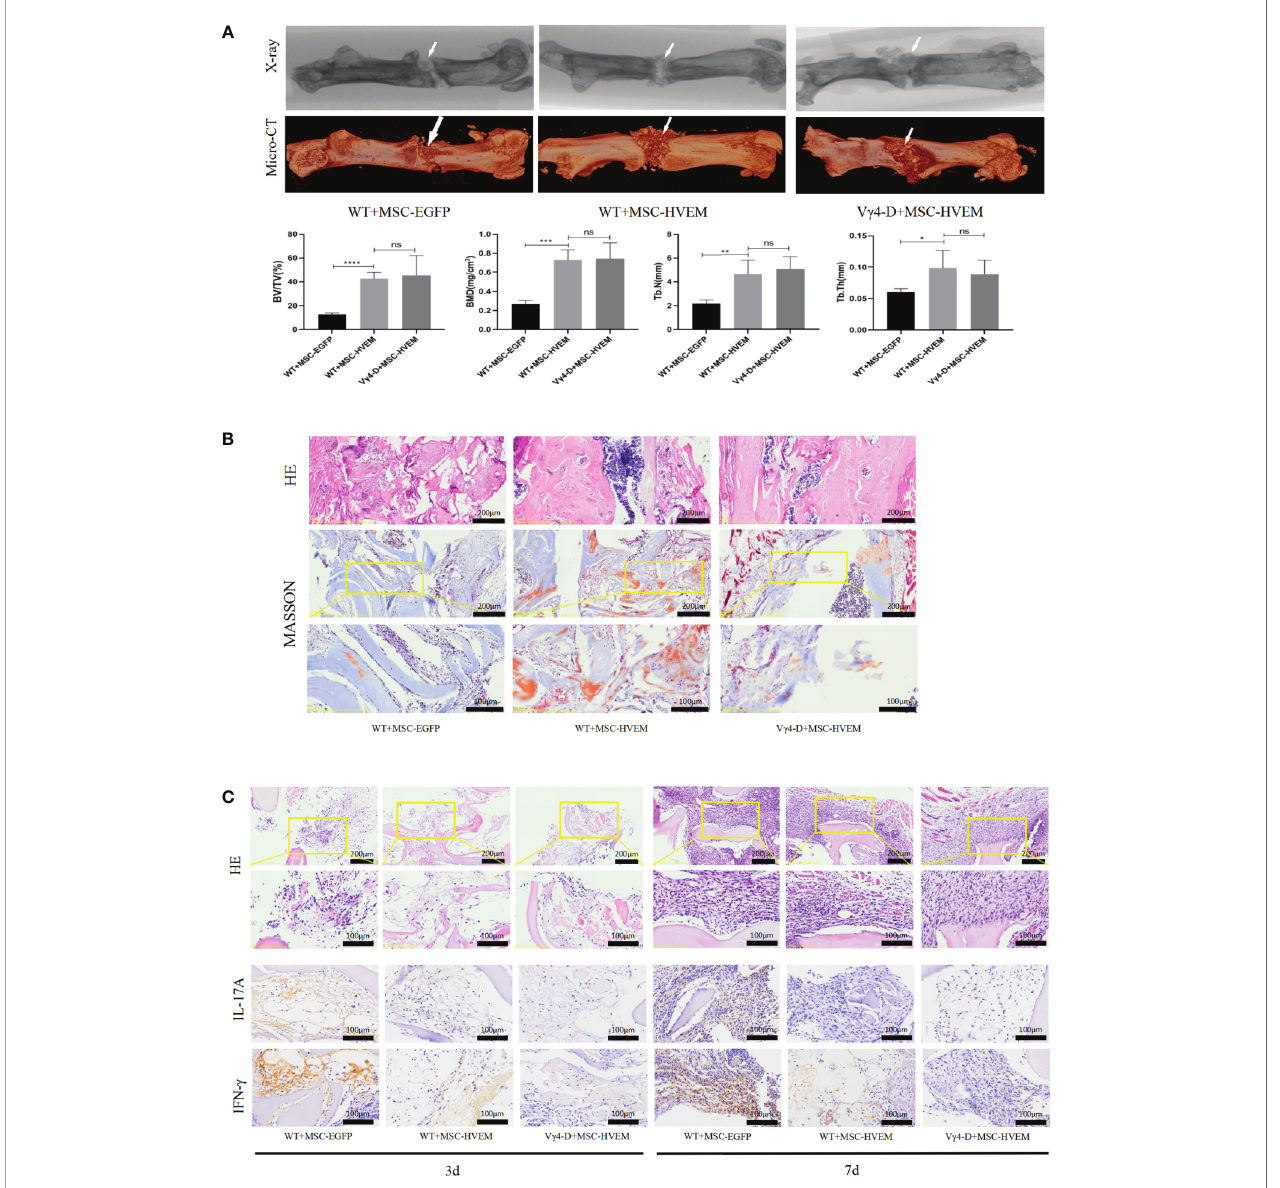
FIGURE 6 | OsteogenicabilityandLocal immuneresponseofTEB constructed byMSC HVEM invivo. (A) BothWT+MSC HVEM groupsandVY4-D+MSC HVEM groups show higher qualityofbone formationthanthat ofWT+MSC inBV/TV, BMD, Tb.N,Tb.Th, butthe qualityofbone formationofbetweenWT+MSC HVEM groups and VY4-D+ MSC HVEM groups hadno statisticsdifference(P > 0.05). (B) Histological analysis ofnewly formedbone byH&EandMasson ’ s Trichrome stainingin3 groups. (C) In fi ltrationofin fl ammatory cellsandexpressions ofIL-17A and IFN- g detectedbyimmunohistochemistry at 3days and7 dayspostimplantation. Error bars represent mean±SD. One-wayANOVA test wasused to calculatedP value (*P < 0.05, **P < 0.01, ***P< 0.001, ****P < 0.0001, ns P>